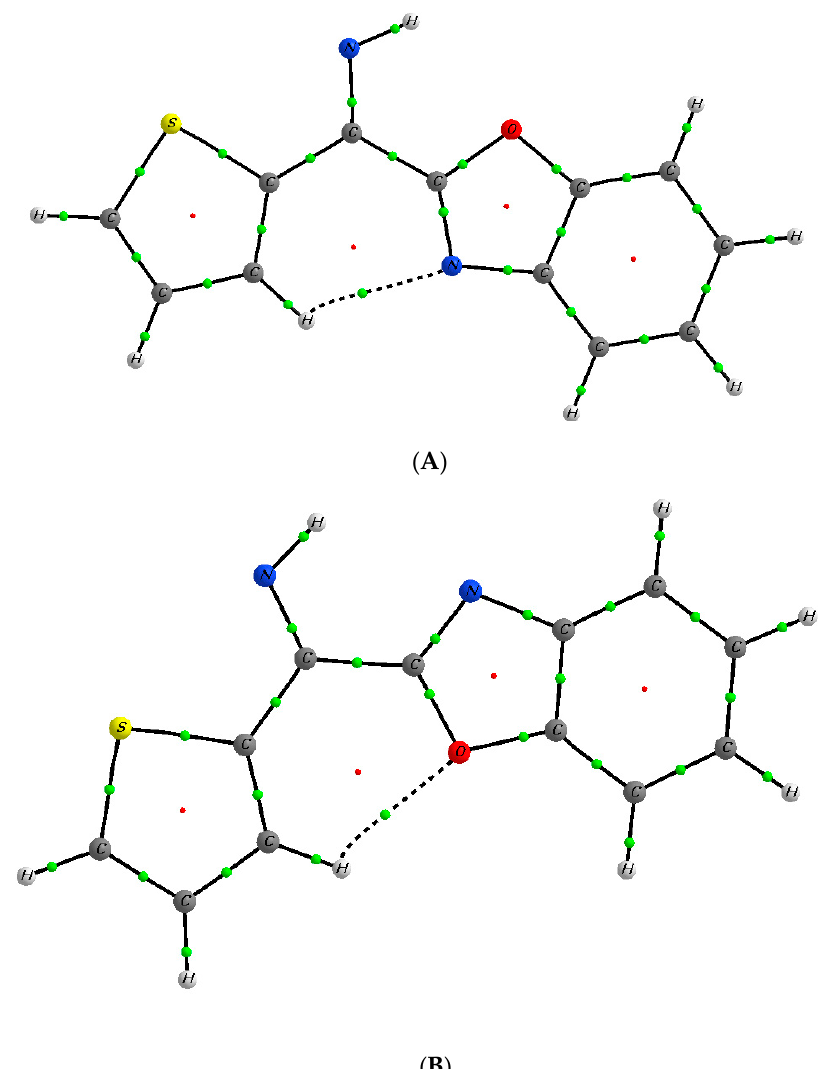
Figure 2. The molecular graphs of two isomers with trans- ( A ) and cis- ( B ) disposition of C=N bonds. The critical points (3, − 1) and (3, +1) are shown by small green and red balls. The bond path for C-H···O and C-H···N interactions are shown by dashed lines.